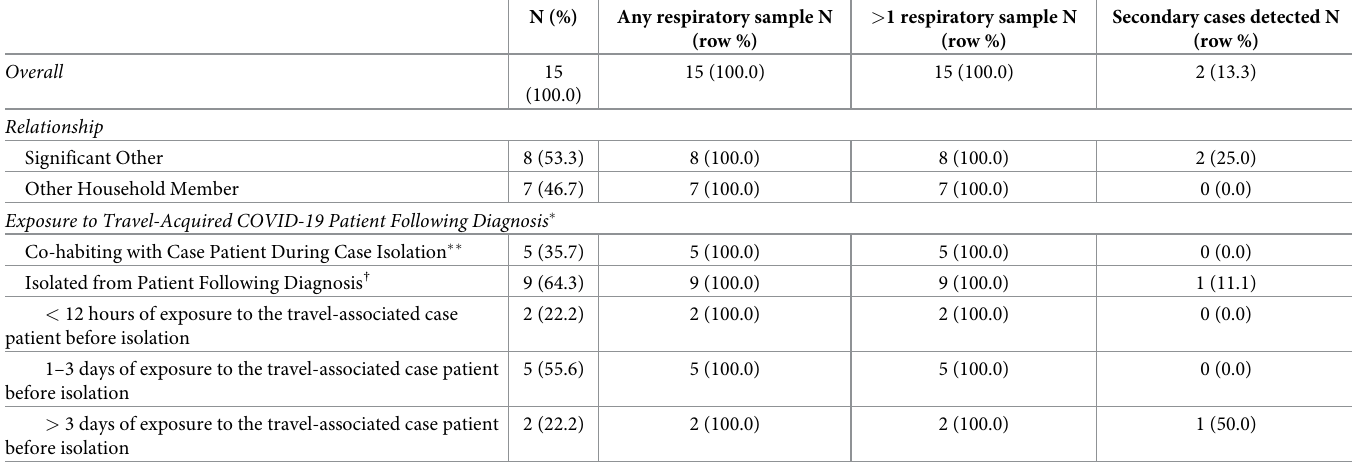
Table 2. Description of household contacts of confirmed travel-acquired COVID-19 case patients (N = 15), United States, January–February